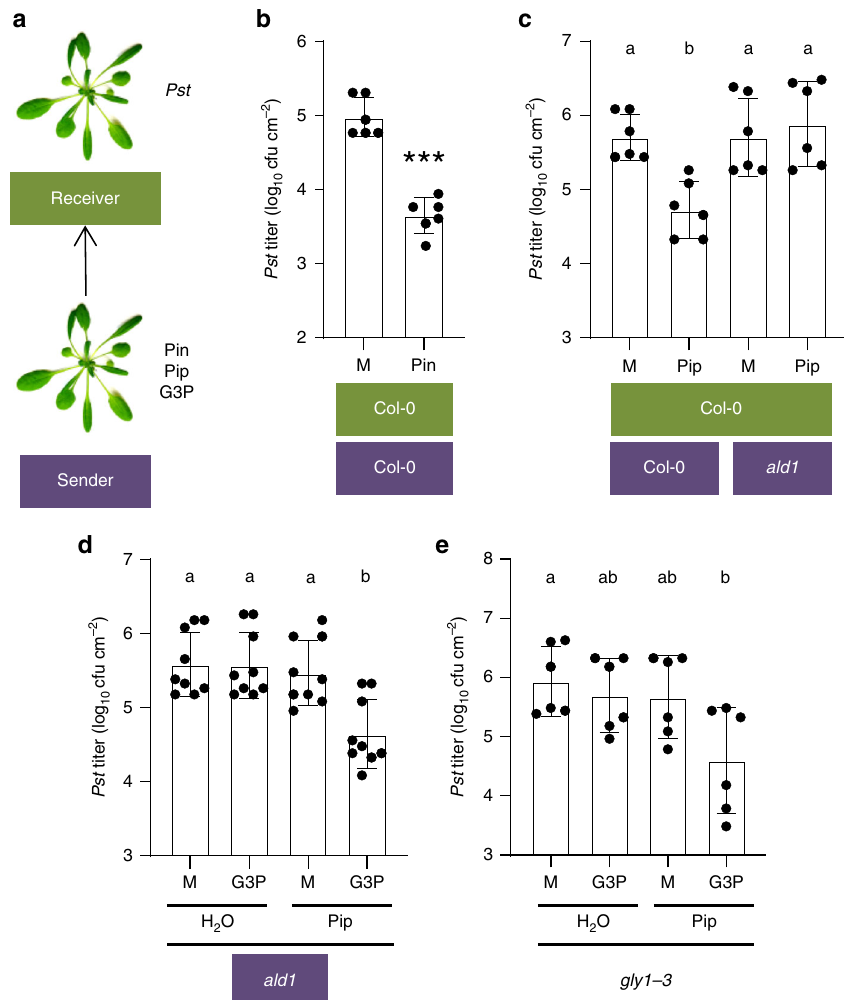
Fig. 7 Pip and G3P cooperate to promote SAR and PTP cues. a Experimental setup of ( b – d ). Senders were exposed to Pin, treated with Pip and/or G3P, or exposed to the appropriate mock controls, and incubated with naive receivers in gas-tight containers. The receivers were subsequently released from the containers and inoculated with Pst . b , c In planta Pst titers at 4 dpi of the receivers. The plant genotypes are indicated below the panels (senders in purple and receivers in green) and the treatments of the senders are indicated below the bars. d Chemical complementation of the PTP-signaling defect of the ald1 mutant with Pip and G3P. ald1 senders were irrigated with Pip or the corresponding H 2 O control and subsequently syringe-in fi ltrated in the leaves with G3P or the corresponding mock control as indicated below the panel. The treated plants were incubated with Col-0 wt receivers in gas-tight containers. The receiver plants were subsequently released from the containers and inoculated with Pst . The resulting in planta Pst titers at 4 dpi are shown. e Chemical complementation of the SAR-de fi cient phenotype of the gly1-3 mutant with Pip and G3P. gly1-3 mutant plants were irrigated with Pip or the corresponding H 2 O control and subsequently syringe-in fi ltrated in the fi rst two true leaves with G3P or the corresponding mock control as indicated below the panel. Leaves systemic to the site of G3P application were inoculated with Pst , and the resulting in planta Pst titers at 4 dpi are shown. b – e Dots indicate individual results from two ( b , c , e ) to three ( d ) biologically independent experiments, including three replicates each. Bars represent the average of the indicated results ± standard deviation. b Asterisks above bar indicate a signi fi cant difference from the mock control ( t test, P < 0.001). c – e Different letters above bars indicate signi fi cant differences, one-way ANOVA, P <